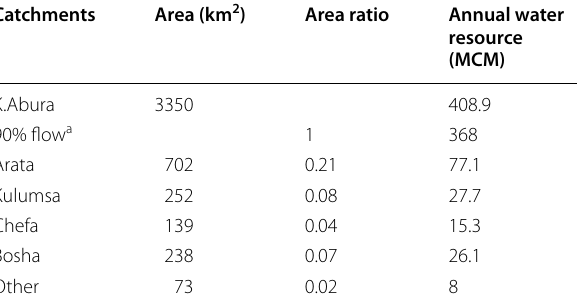
Table 2 Annual water resources of Ketar and Arata catchment